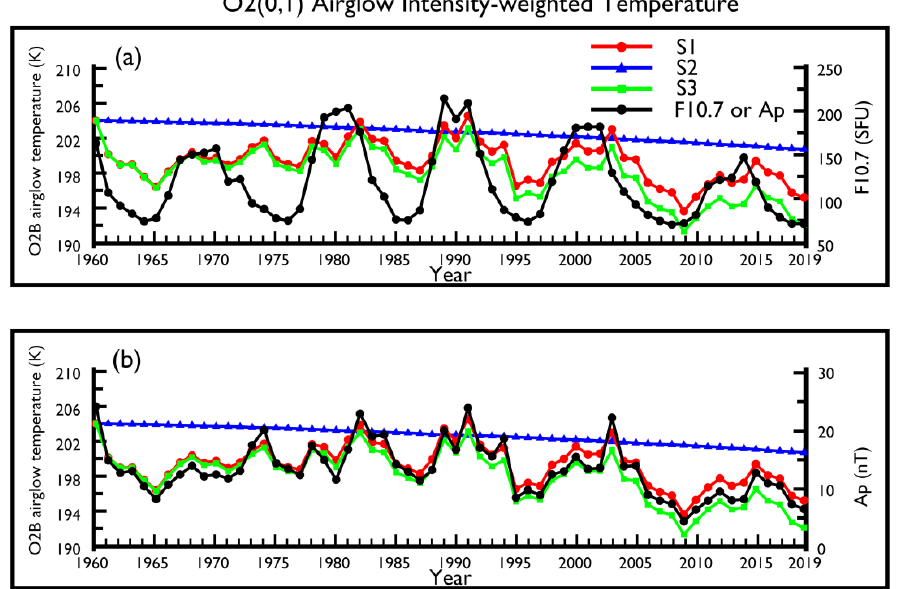
Figure 2. ( a ) Time series of the simulated O 2 temperature (axis on left) and F10.7 (axis on right) in Figure 2. Same as Figure 1, but for the simulated O 2 temperature. the top panel for the three scenarios. ( b ) The same plot but with Ap index (axis on right) is on the bottom